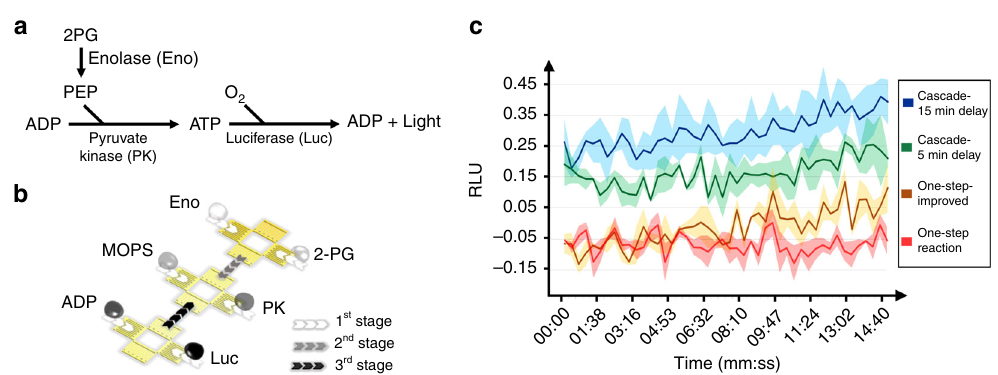
Fig. 7 Enzyme cascade reaction for detecting enolase on a digital acousto fl uidic device. a The mechanism of enolase detection. b Illustration of the six- droplet-merging sequence of the cascade reaction for enolase detection. c A comparison of the results for detecting 50 ng mL − 1 of enolase with respect to elapsed time, performed using the one-step reaction on a plate and the cascade reaction using digital acousto fl uidics. The relative luminescence units (RLU) are normalized to the negative control (no enolase) case. For the classic one-step reaction (red curve), the entire reaction mixture is applied to enolase sample immediately. In the improved one-step reaction con fi guration (yellow curve, labeled ‘ One-step-improved ’ ), the reaction mix is incubated for 5 min to wait for the background from 2-PG, ADP, Luc to fade before adding the enolase sample. For the cascade reactions, the enolase sample is fi rstly incubated with 2-PG for 5 min (green curve, labeled ‘ Cascade-5 min delay ’ ) or 15 min (blue curve, labeled ‘ Cascade-15 min delay ’ ) to produce an extra amount of PEP, which will then trigger a more intense signal increase with the other enzymes and